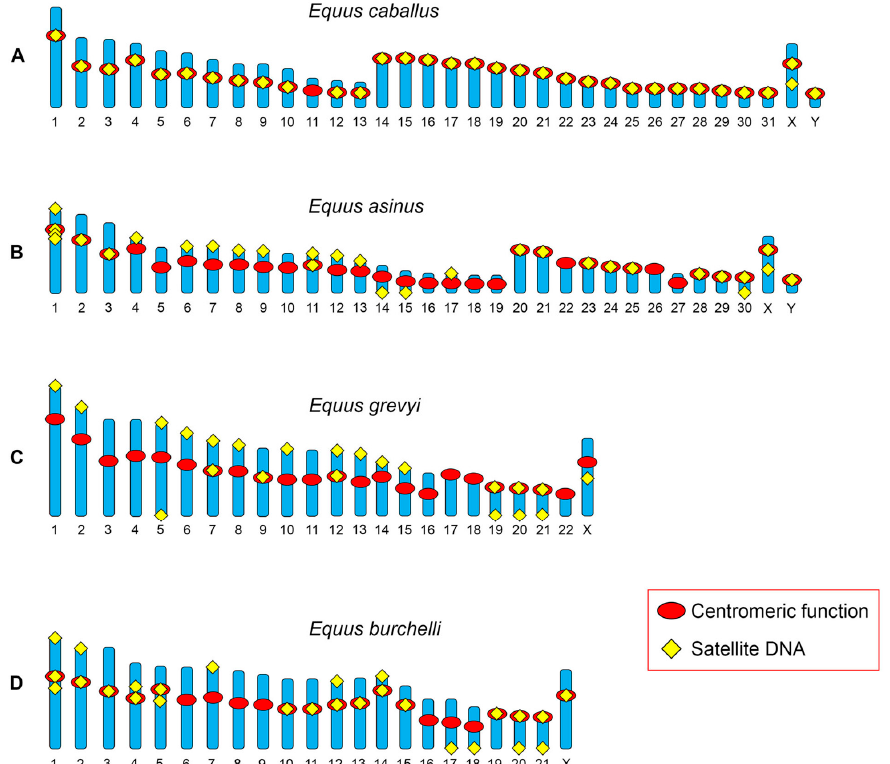
Figure 1. Schematic representation of the chromosomal distribution of satellite DNA obtained by FISH experiments in E. caballus , E. asinus , E. grevyi and E. burchelli . ( A ) In E. caballus , all centromeres, with the exception of that of chromosome 11, are associated with satellite DNA sequences. Satellite DNA is also present at an interstitial position on the long arm of chromosome X. ( B ) In E. asinus , 18 centromeres are not associated with satellite DNA sequences at the FISH resolution level. Satellite DNA sequences are present at 13 non-centromeric chromosome ends. Satellite DNA is present at an interstitial position on the long arm of chromosome X. ( C ) In E. grevyi , 17 centromeres are void of satellite DNA and satellite DNA sequences are present at 15 non-centromeric termini and at an interstitial position of the long arm of the X chromosome. ( D ) In E. burchelli , 7 centromeres do not display satellite DNA sequences and 9 non-centromeric chromosome ends are associated with satellite DNA. Satellite DNA loci are present in the pericentromeric region of chromosomes 1, 4 and 5. Modified from [14] .